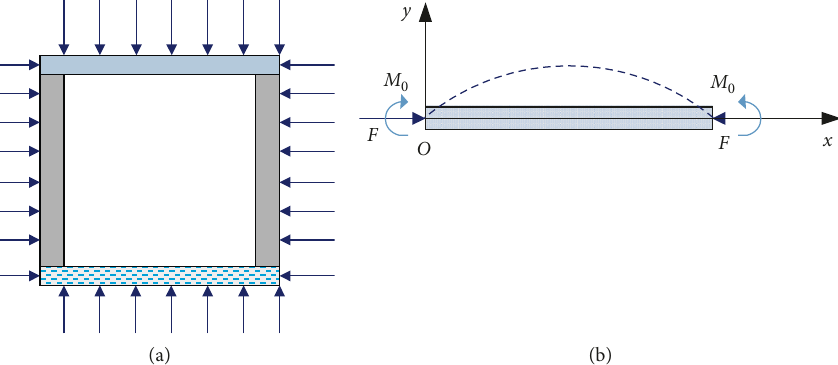
Figure 8: Simplified model of the roadway floor force. (a) Stress analysis of roadway-surrounding rock. (b) Stress analysis of floor